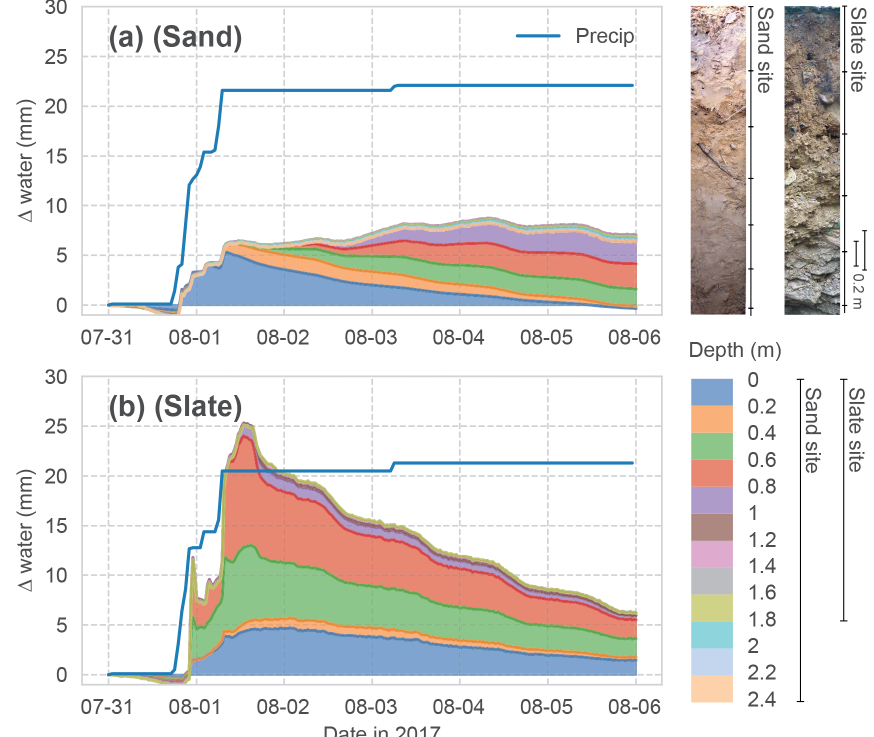
Figure 2. Event water balance observed at both sites. The stacked change in soil water content in each monitored soil depth is shown. Cumulated above-canopy precipitation input is given as the blue line. The other colours correspond to the different depths in the soil profiles, as shown in the legend. Two profile images give an impression of the soil conditions at the two